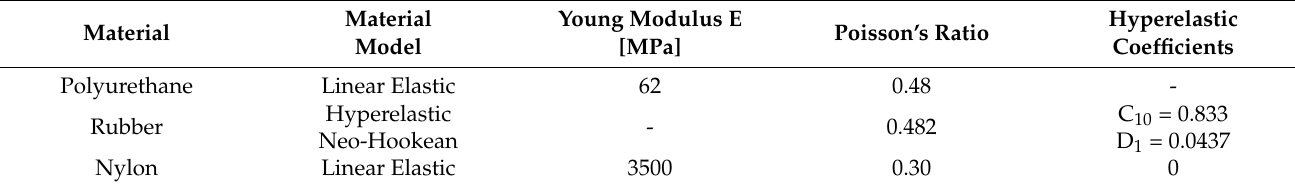
Table 2. Material